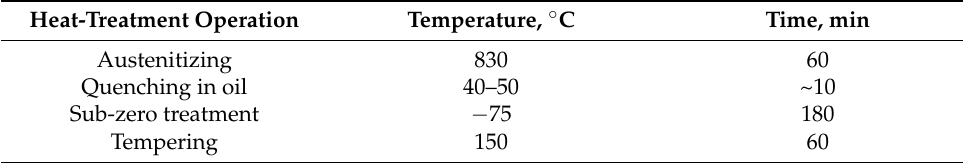
Table 3. Heat-treatment process after low-pressure